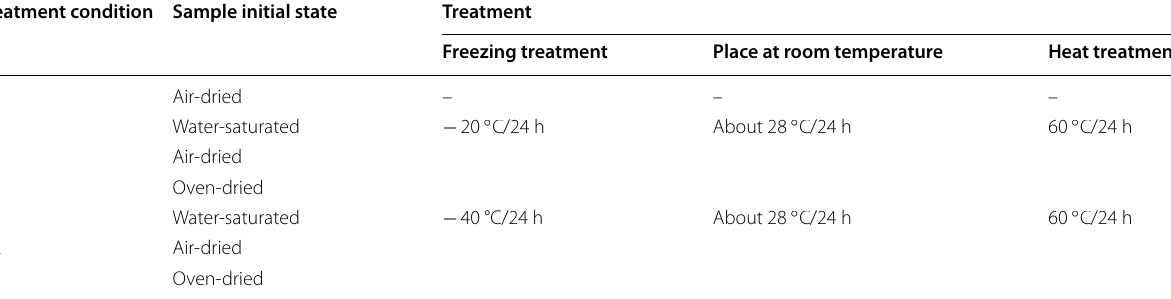
Water-saturated: the sample was placed in the water for 24 h, the moisture content of the samples from the inner layer and the outer layer of bamboo was about 65% and 80%, respectively; air-dried: the sample was dried in the oven at 60 ◦ C until the weight was stable and the moisture content of the samples was about 8–12%; oven-dried: the sample was dried in the oven at 103 ◦ C until the weight was stable and the moisture content of the samples was 0% The parameters of the freeze–thaw treatment were set according to the ASTM D